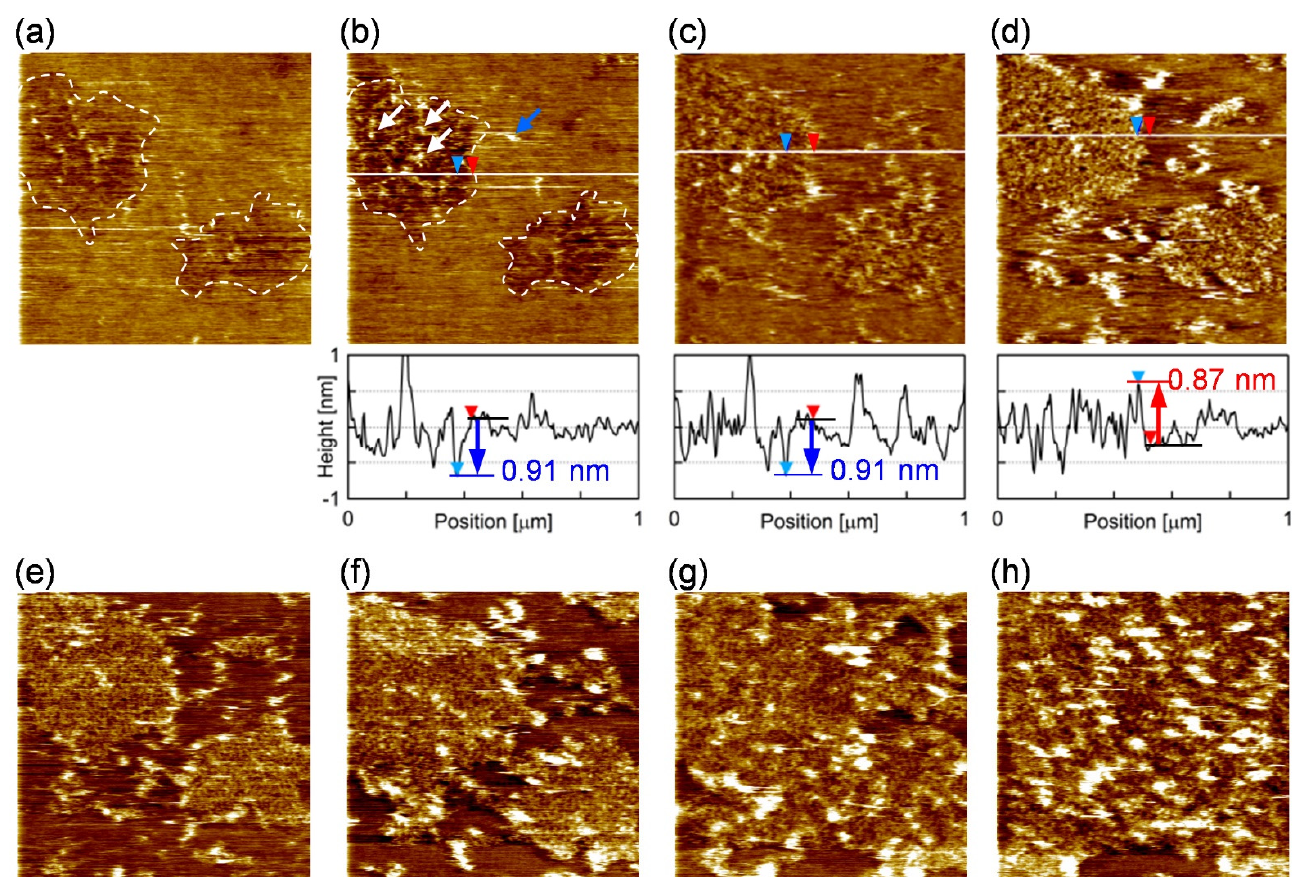
Figure 5. Snapshots from the sequence of AFM topographies (1.0 × 1.0 µm 2 ) of the PI+PC-SLB ( a ) 203 s, ( b ) 376 s, ( c ) 897 s, ( d ) 1418 s, ( e ) 1962 s, ( f ) 2679 s, ( g ) 3753 s, and ( h ) 6260 s after the addition of FBP-17. The cross-section profile at the white line is accompanied in ( b – d ). The depression microdomains in the view filed is marked with the dashed line in ( a , b ). Representative protrusions in the microdomain and the surrounding region were indicated by white and blue arrows, respectively, in ( b ). In the cross-section profiles, the level of the surrounding region is represented by a black line with a red triangle; the level of the microdomain is represented with a blue line or a red line with a blue triangle, in case the microdomain is depressed or protruded from the surrounding region, respectively.